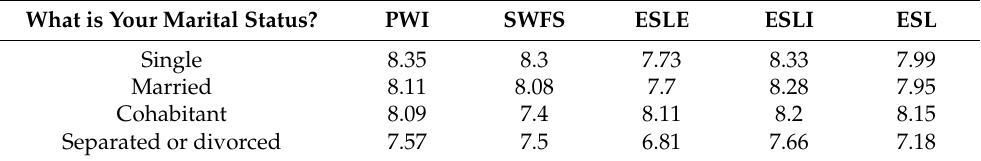
Table 5. Means according to marital